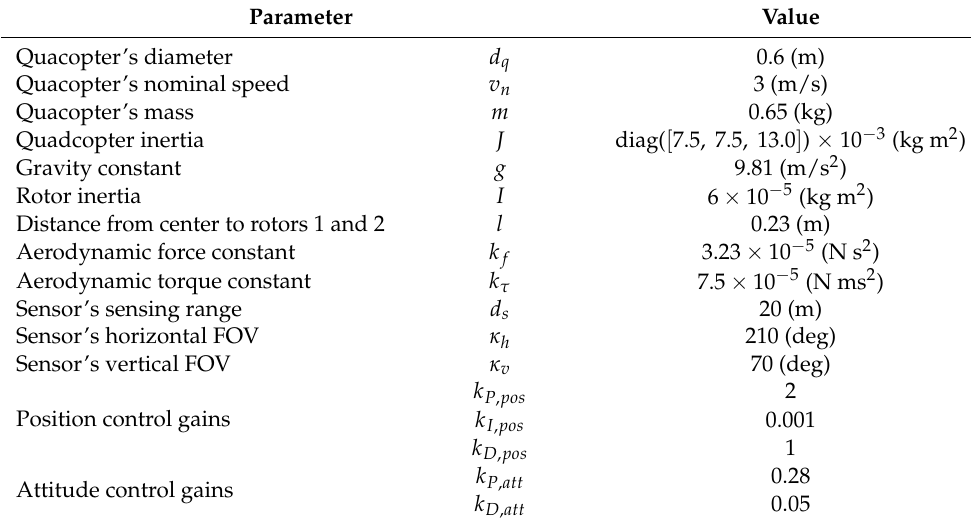
Table 3. Simulation parameters for the quadcopter system.